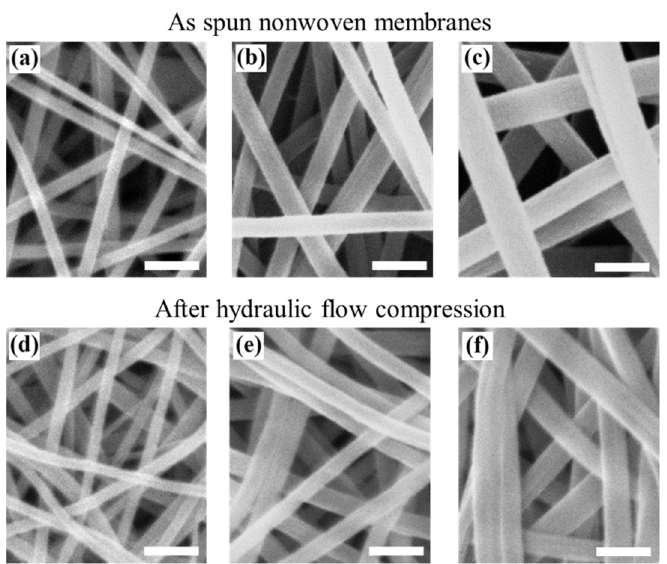
Figure 2. SEM images of electrospun nonwoven PAN membranes with various fiber diameters be- fore the hydraulic tests ( a – c ) and after the hydraulic tests ( d – f ) (scale bar: 1